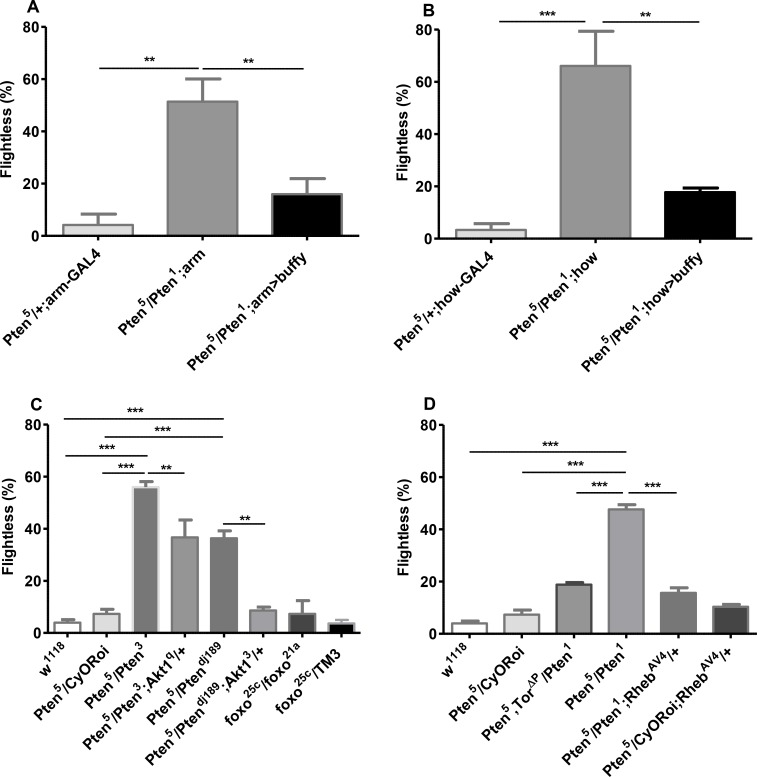
The Pten
5 transheterozygous flightless phenotype involves muscle-specific defects and is suppressed by reducing Akt/mTORC1 signalling.(A) Overexpression of the Bcl-2 homologue buffy with the ubiquitous arm-GAL4 driver rescues the Pten
5
/Pten
1 transheterozygous mutant flightless phenotype in 9-day-old females; pooled data from nine experiments; **P < 0.005, n ≥50. (B) Similarly, overexpression of buffy with the how-GAL4 muscle-specific driver also rescues the Pten
5
/Pten
1 flightless phenotype in females; pooled data from six experiments; *** P < 0.002, n ≥ 50. (C) Reducing IIS through heterozygous loss-of-function Akt1
q and Akt1
3 alleles significantly suppresses the Pten
5 transheterozygous mutant flightless phenotype in females, while transheterozygous foxo
25c/foxo
21a null females does not behave significantly differently from foxo
25c/TM3, Pten
5
/CyORoi or w
1118 controls. Data are pooled from at least six experiments. **P < 0.01, n ≥ 70 for Akt1
q, n ≥148 for Akt1
3, n ≥ 80 for foxo experiment. (D) Reducing mTORC1 signalling in flies heterozygous for the Tor
ΔP (pooled data from fifteen experiments, n ≥ 139) or Rheb
AV4 (pooled data from four experiments, n ≥ 140) loss-of-function alleles significantly suppresses the Pten
5
/Pten
1 transheterozygous flightless phenotype in females; ***P < 0.001. Significance was determined by one-way ANOVA with Bonferroni post-hoc correction test.